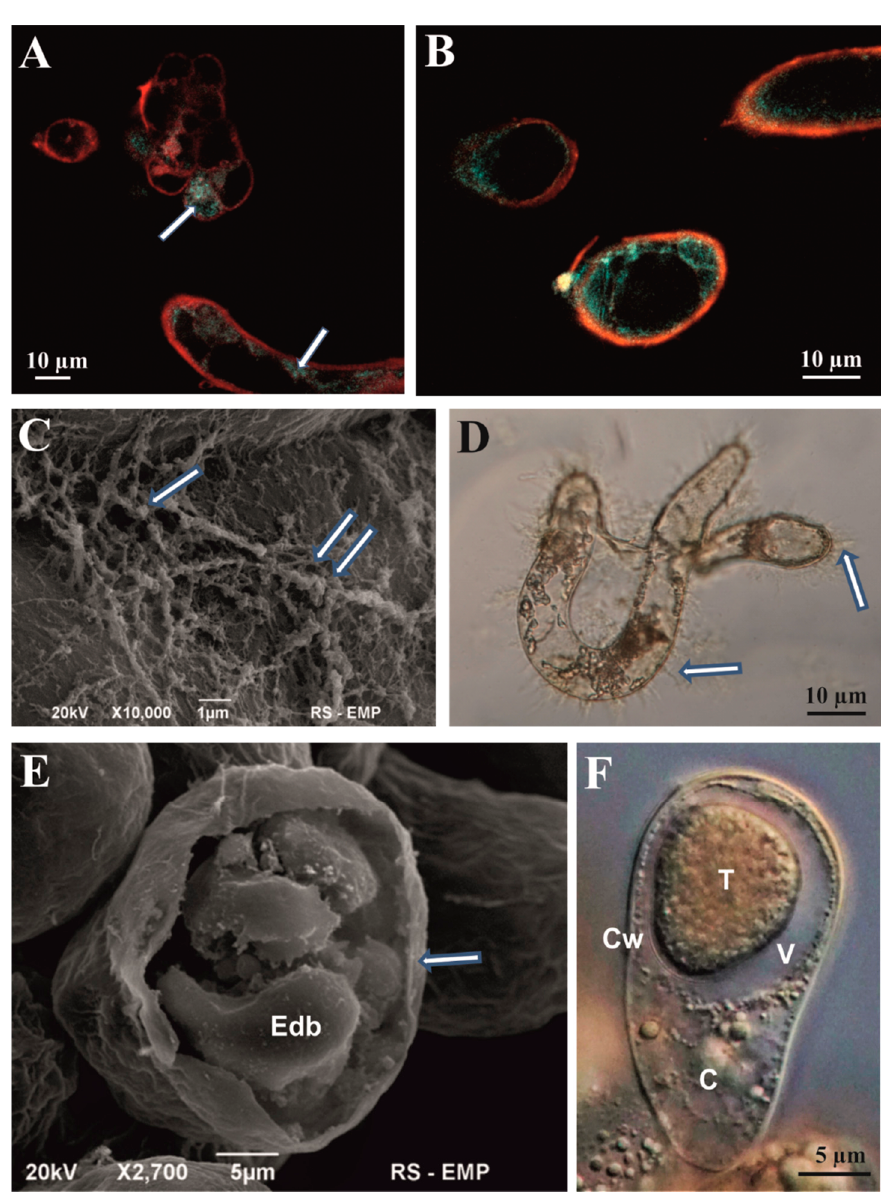
Figure 5. Structural evidence of the cell suspension metabolic activity. ( A ) Autofluorescence of small, actively dividing cells of the cell aggregate and of long differentiated cells; arrows show the condensation of tannins. ( B ) Autofluorescence of single cells. ( C ) Cell wall coated by a “net” or reticulum of granular (single arrow) and filamentous (double arrow) metabolites released by the cell. ( D ) Active production of metabolites by non-mitotically active cells (the transparent filaments) and their release outside the cell. ( E ) Opened marginal cell of aggregate in “cross-section” showing electron-dense bodies. ( F ) Large dense body located in a number of dense bodies. Cw—Cell wall; V—Vacuole; C—Cytoplasm; T—Body of tannins. ( A , B )—confocal microscopy; ( C , E )—scanning electron microscopy; ( D , F )—light microscopy with Nomarski contrast (squashed specimen).